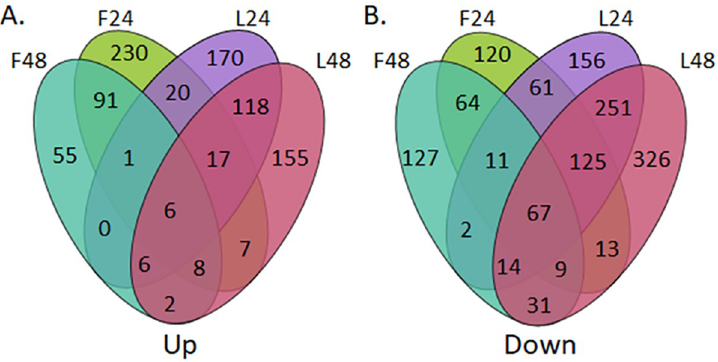
Fig 3. Venn diagram showing in-common and unique responses for the two treatments in gene expression space. Note that few up-regulated genes (A) are shared by the two treatments, in contrast to a much higher overlap in down- regulated genes (B). F24—represents the expression of a gene after 24h treatment with fucoxanthin; F48—represents the expression of a gene after 48h treatment with fucoxanthin; L24—represents the expression of a gene after 24h treatment with LY-294002; L48—represents the expression of a gene after 48h treatment with LY-294002.